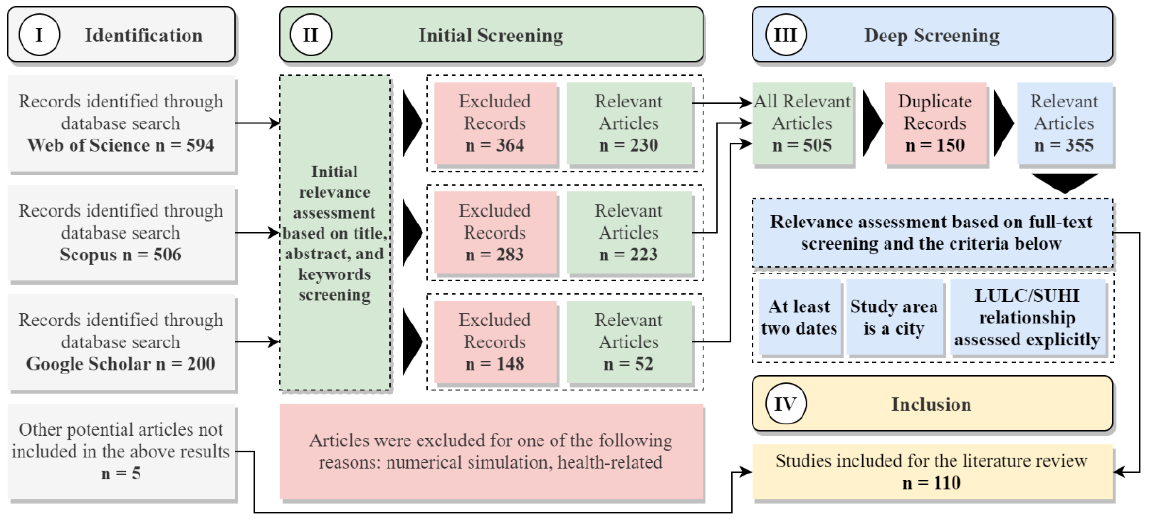
Figure 1. Methodological flowchart.